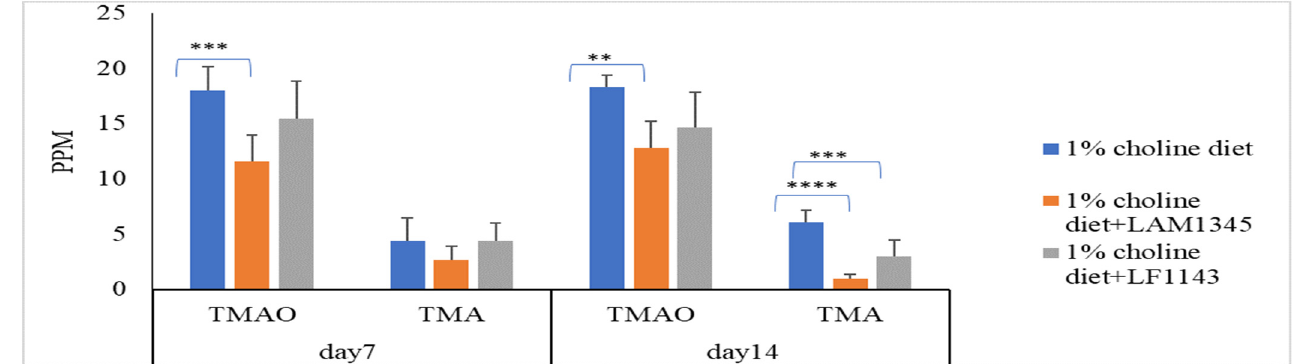
Figure 3. Effect of L. amylovorusLAM1345 and Lim. fermentum LF1145 on serum TMAO and TMA levels. Experimental conditions were as described in Methods. Values are represented as mean values ± SD ( n = 7) * p <0.05, ** p < 0.01, *** p <0.001, **** p < 0.0001.